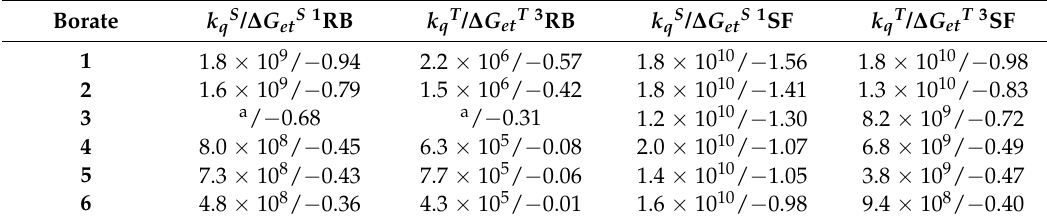
Table 2. Quenching rate constants k qS,T (M − 1 · s − 1 ) for the excited states of the dye in acetonitrile and the corresponding Gibbs free energies ∆ G et (eV)